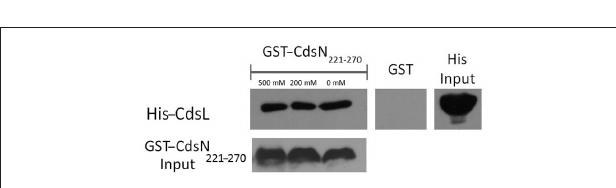
FIgure 3 | The CdsN peptide, containing both the predicted 221–270 CdsN–CdsL binding domains, co-purifies with CdsL. GST–CdsN bound to glutathione beads and used to pull-down His–CdsL from Escherichia coli lysates. Beads were collected by centrifugation, washed with 0, 200, and 500 mM NaCl and probed for His-tagged protein by Western blot using anti-His antibody. GST–CdsN co-purified with CdsL while GST alone did 221–270